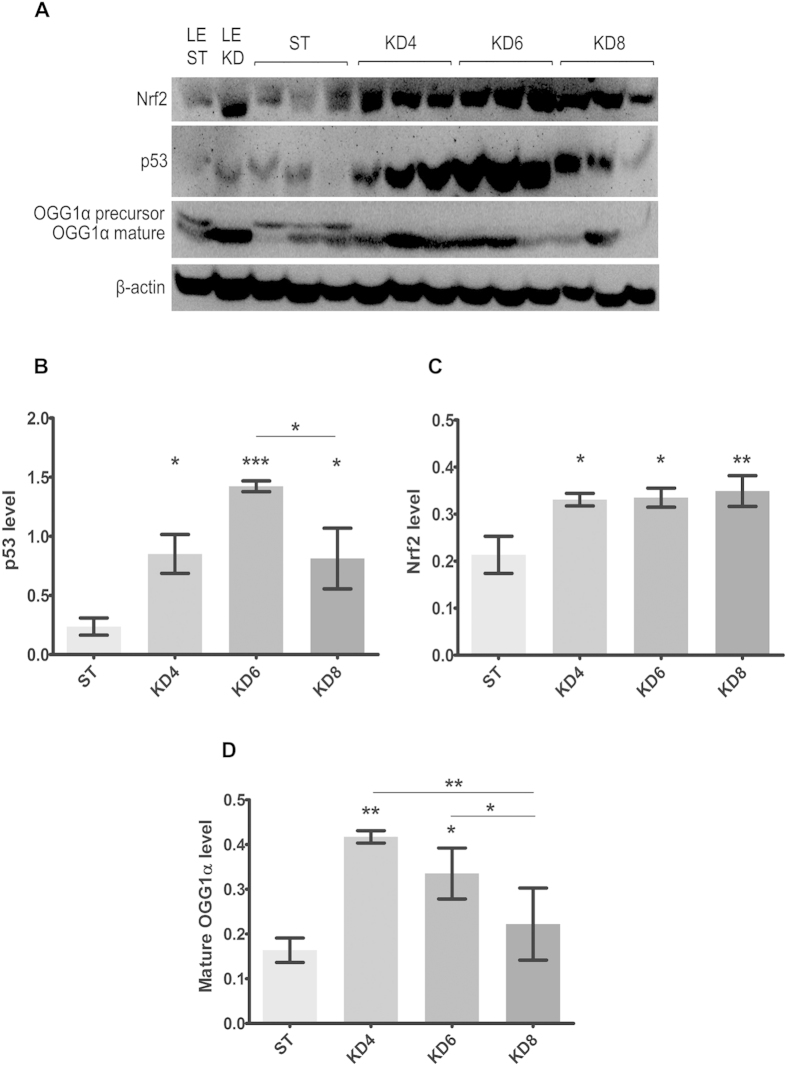
Immunoblot analysis of kidney lysates.(A) Blot membranes were incubated with the antibodies against Nrf2, p53 and 8-oxoguanine glycosylase α (OGG1α). The mean integrated optical density is related to actin for Nrf2 (B), p53 (C) and mature 8-oxoguanine glycosylase α (D) levels. Results are given as a mean ± S.E.M. KD4, KD6, KD8 – groups of Eker rats (Tsc2+/−) treated with HFKD for four, six or eight mo., respectively; ST – Eker rats fed with a standard diet; LE ST – wild-type Long Evans rats treated with a standard diet; LE KD – wild-type Long Evans rats treated with a ketogenic diet similarly to the KD6 group. *P < 0.05, **p < 0.01, ***p < 0.001 as compared to ST unless otherwise stated (horizontal line) for ANOVA with a Fisher post hoc test.